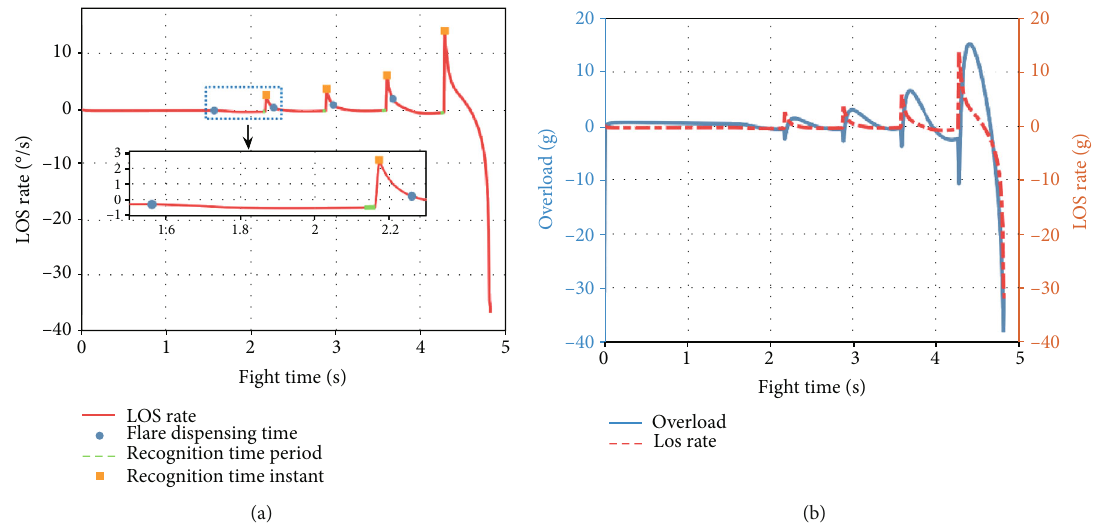
Figure 3: The variation of the LOS rate and overload. (a) The variation of the LOS rate in di ff erent time periods. (b) The variation of the overload with respect to the LOS rate.